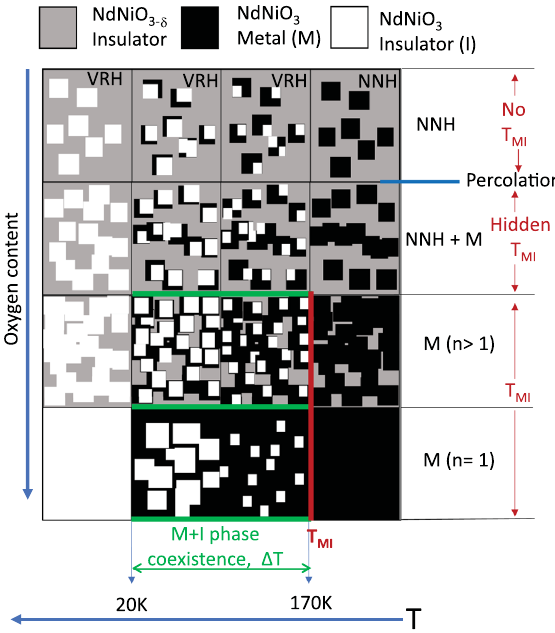
Fig. 4 Illustration of the double percolation model. The sketch shows the evolution of NNO fi lms as a function of oxygen content (vertical) and temperature (horizontal). Gray, black and white denote electron-localized (defective) NdNiO 3 − δ , metallic NdNiO 3 and insulating NdNiO 3 , respectively. The evolution of conduction models as a function of oxygen content (from NNH to NNH + M to M) are denoted. The blue horizontal line signi fi es the metallic percolation threshold. The green horizontal lines indicate the extent of the hysteresis (coexistence of M and I), while the red vertical line points out the measurable T MI